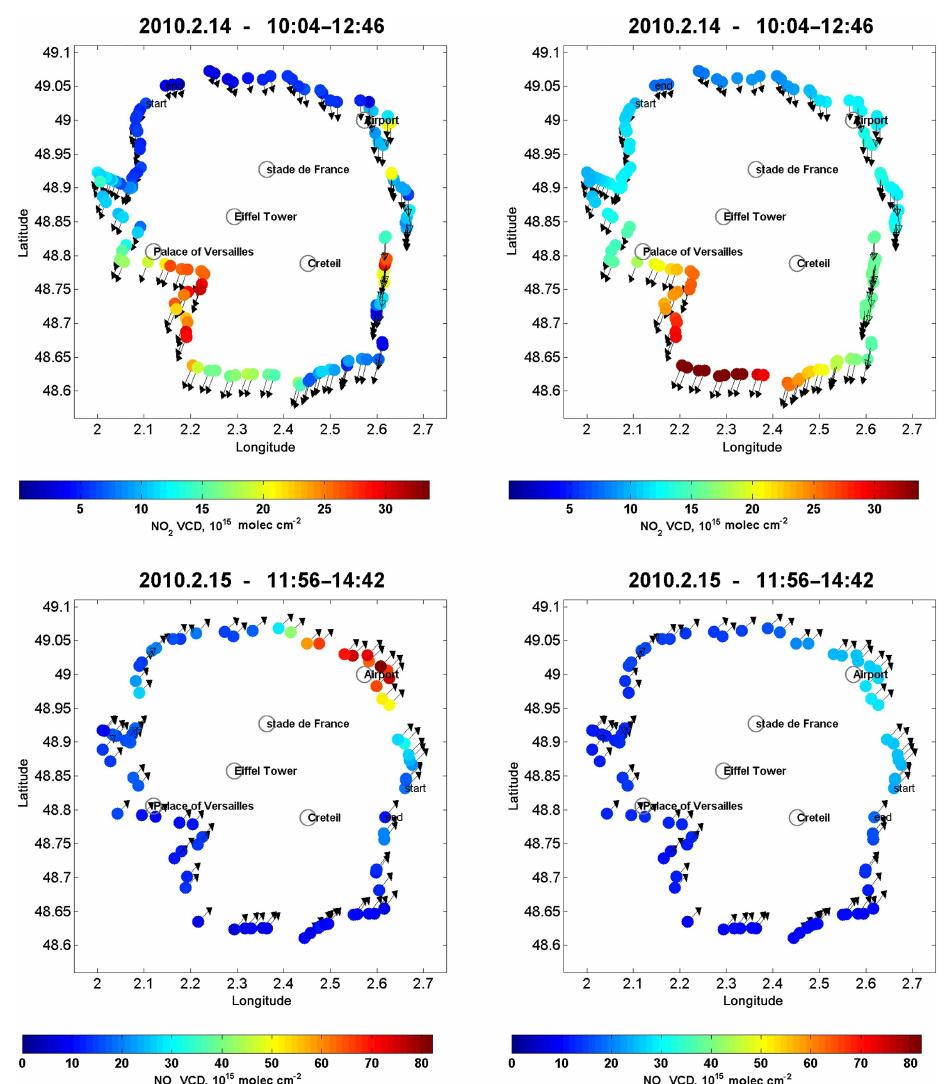
Figure A1. NO 2 VCDs and wind vectors for all days of both campaigns. Left column shows the results of the car MAX-DOAS measurements, and right column shows the corresponding model results. Dates are given as